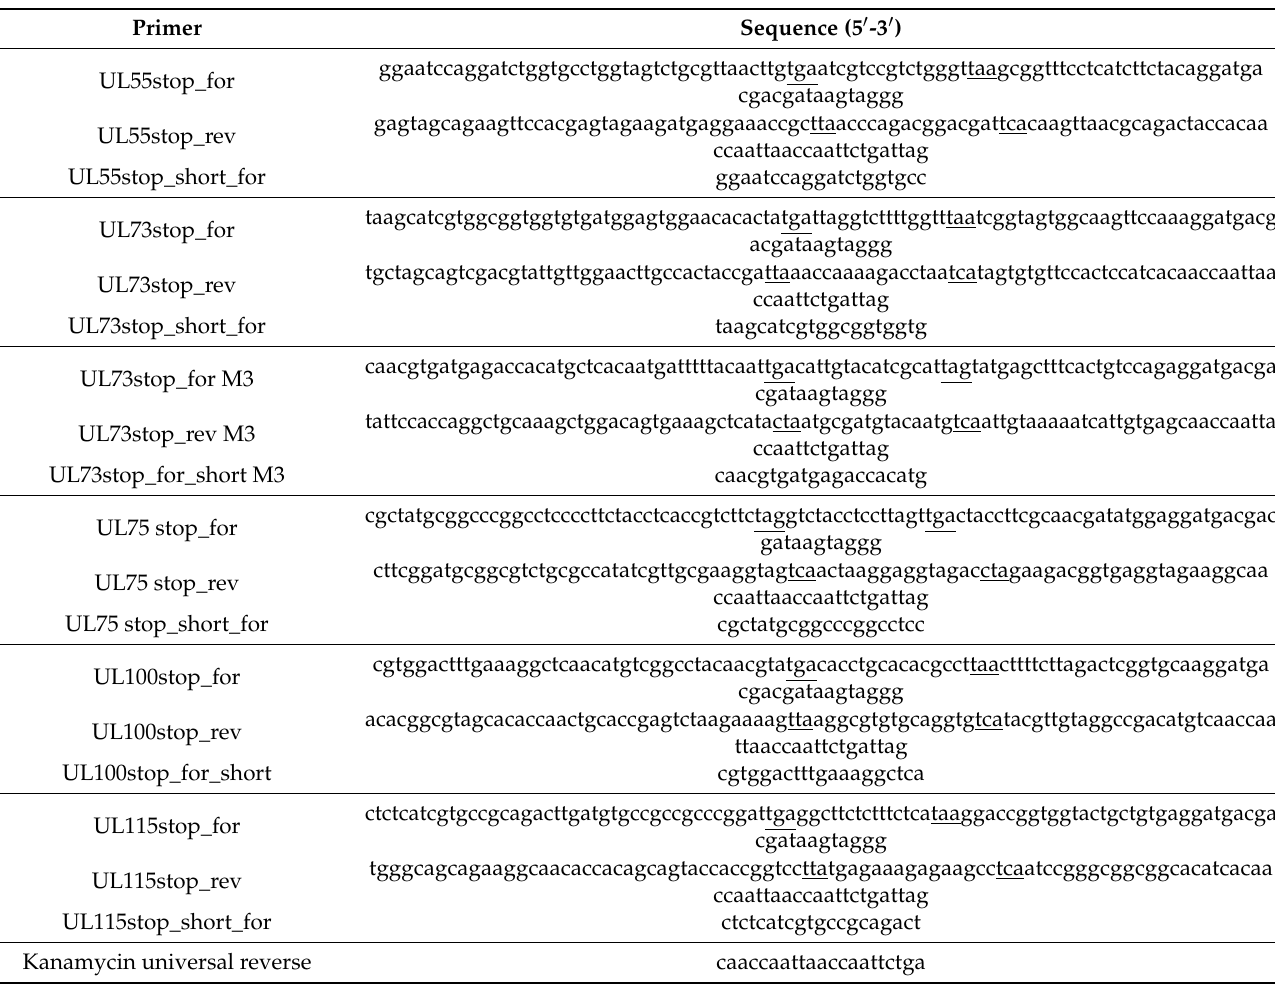
Table 1. Primers used for the introduction of stop codons into glycoprotein genes. Primer